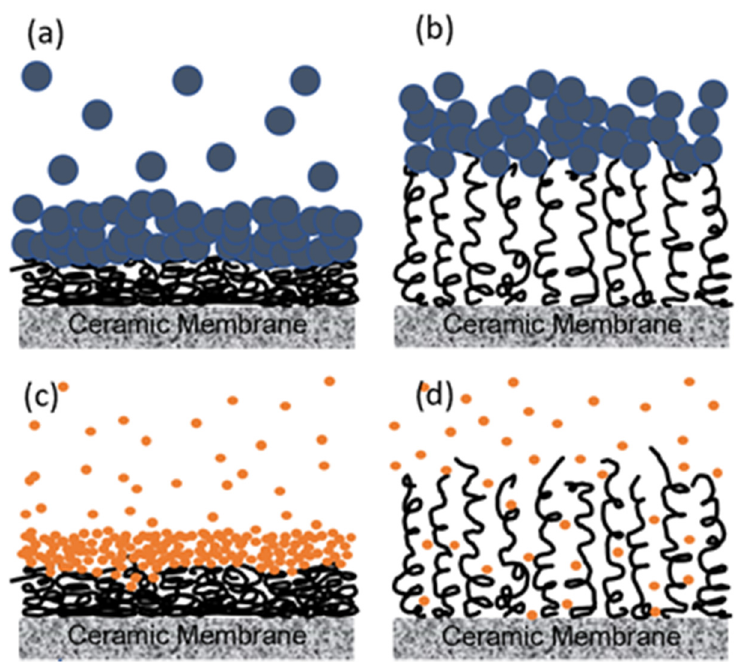
Figure 7. Schematic model illustration of protein fouling with different size foulant molecules at swollen and collapsed tethered polymer layer conformations. ( a ) Collapsed chains of the tethered layer with multi-layer of strongly adhered foulant molecules (BSA) and ( b ) tethered layer of swollen chains. ( c ) Collapsed tethered layer with foulant molecules (Lys) having dimensions smaller than chain-chain separation, and ( d ) swollen tethered chains where foulant penetration and adsorption onto the underlying membrane active layer can occur.